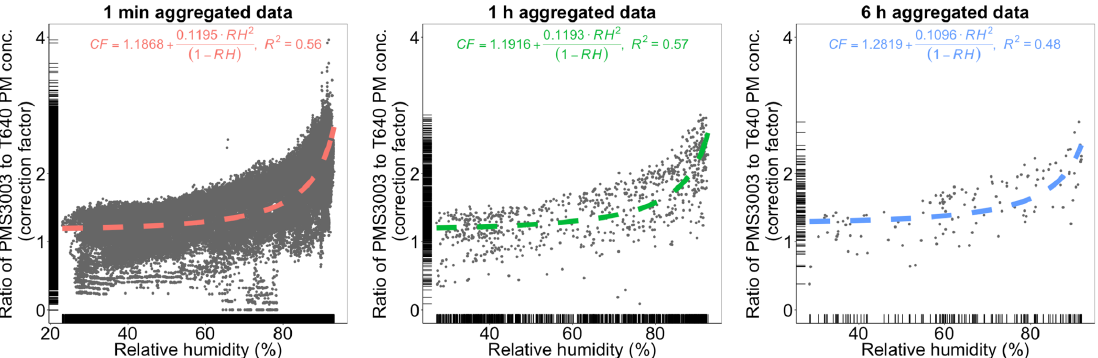
Figure 8. Fractional increase in PM 2 . 5 weight measured by the uncalibrated PMS3003 sensors with respect to RH at 1min, 1h, and 6h time intervals from 30 June and 31 July 2017 at U.S. EPA RTP. RH (%) and PMS3003 PM 2 . 5 concentrations (µgm − 3 ) are arithmetic means averaged across all the three PMS3003 sensor packages at each point in time. The fitted RH adjustment equations and curves were superimposed on the plots. Marginal rugs were added to better visualize the distribution of data on each axis. The results of 12 and 24h aggregated data are not shown as their patterns are relatively